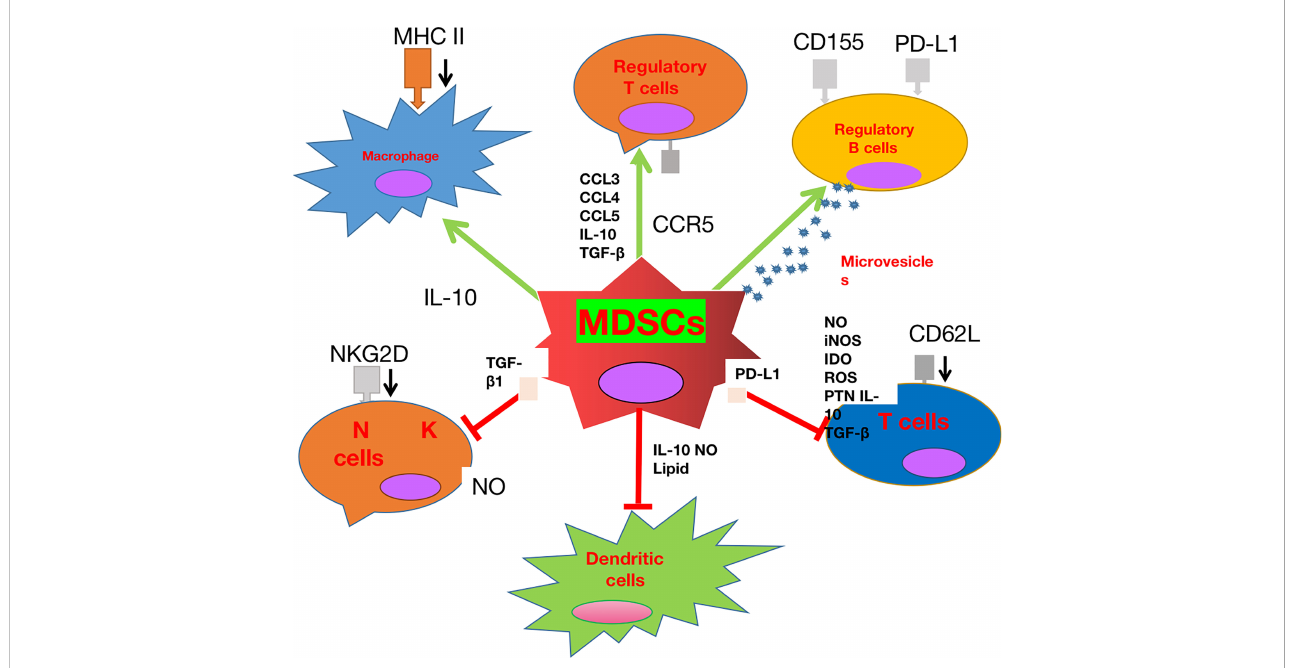
FIGURE 1 The role played by myeloid-derived suppressor cell (MDSC) glioblastoma (GBM). MDSCs can not only inhibit the cytotoxic effect and antigen presentation functions of T cells, natural killer (NK) cells, and dendritic cells (DCs), but also promote the recruitment and stimulation of immune- suppressive M2 macrophages, regulatory T cells (Tregs), and regulatory B cells